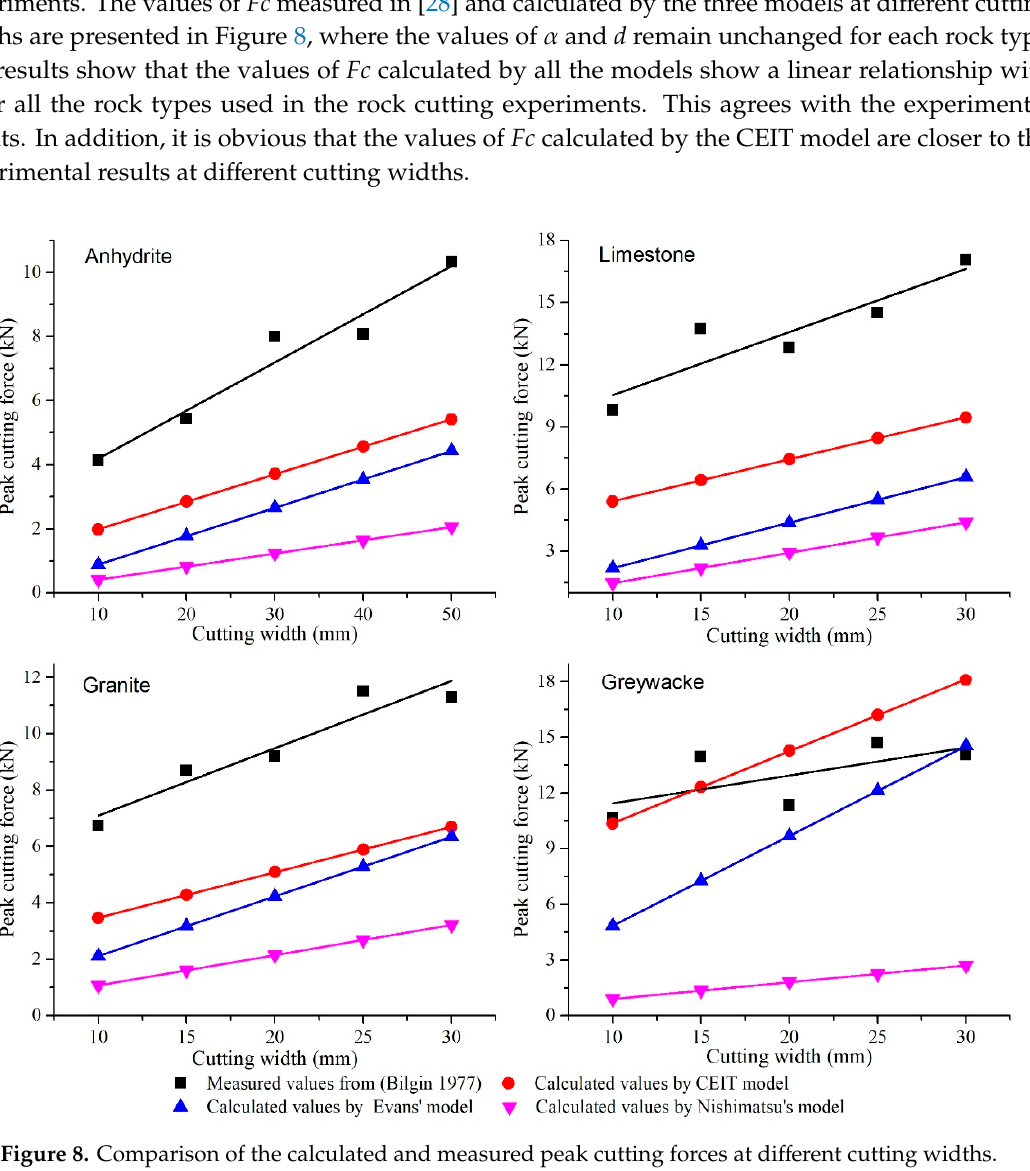
Figure 8. Comparison of the calculated and measured peak cutting forces at different cutting widths.